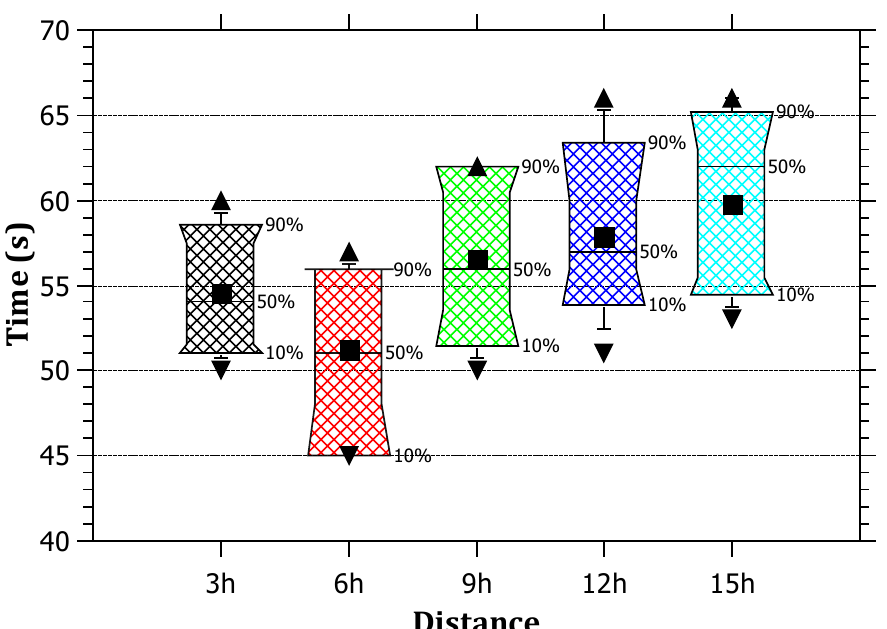
Figure 8. The relationship between the distance of the attack and its detection time.